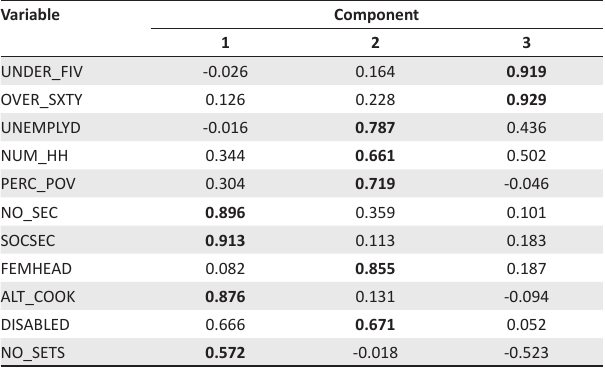
TABLE 4: Rotated component matrix. †